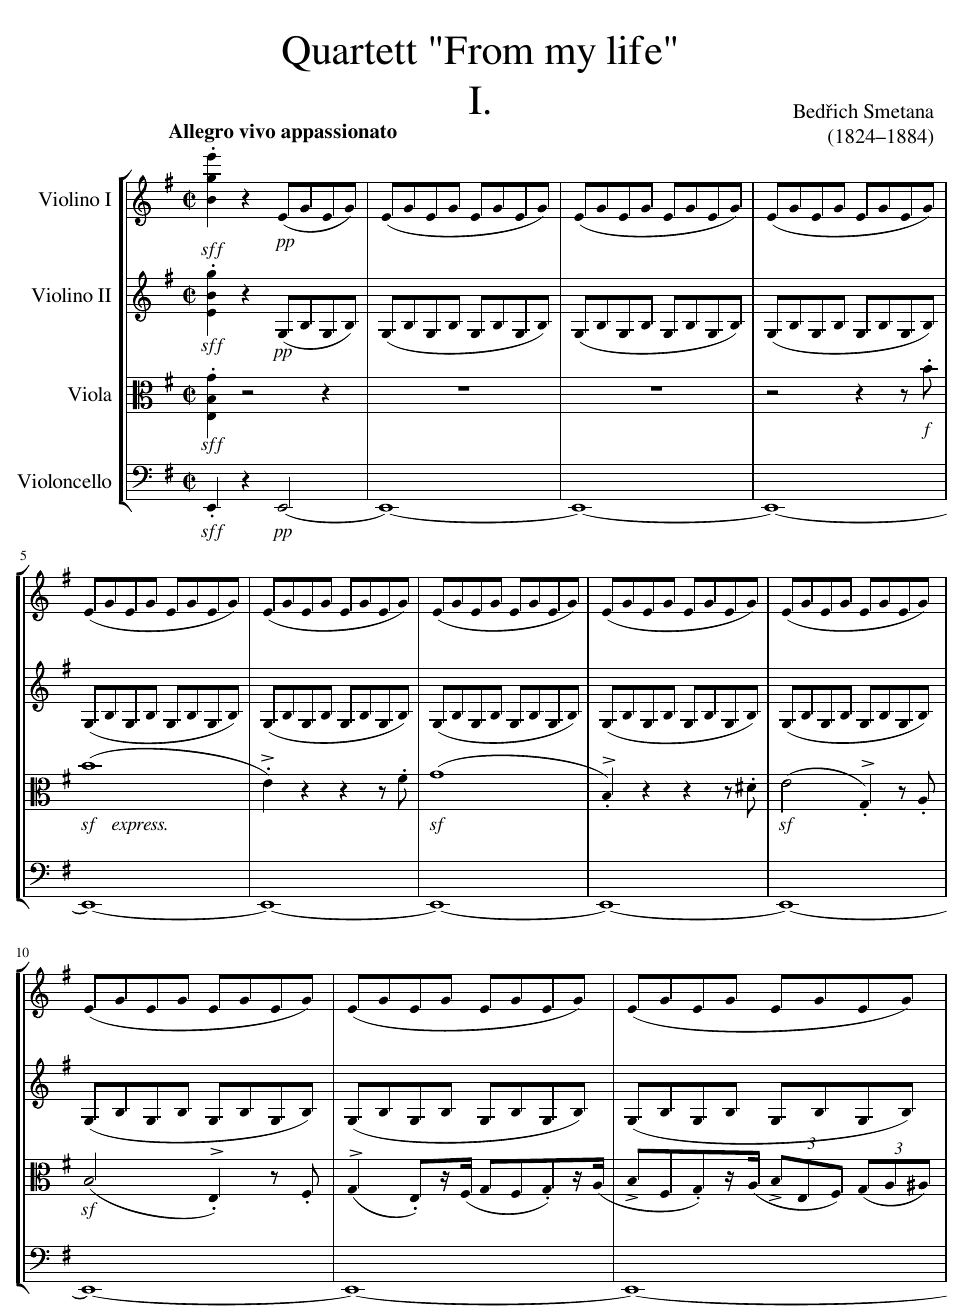
Figure A1. The beginning of the first